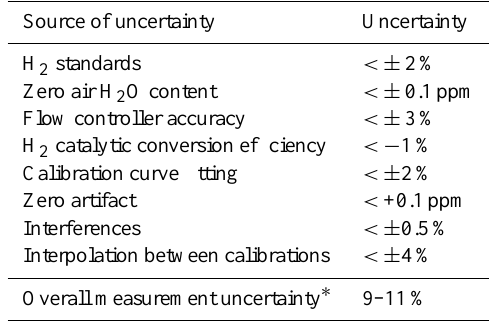
Table 2. Summary of components of uncertainty for the H 2 O CIMS measurement during the MACPEX campaign.